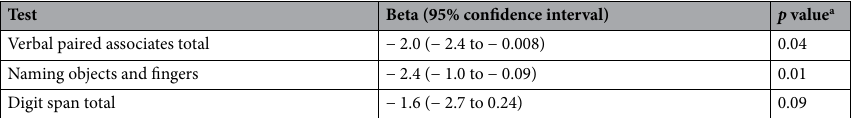
Table 3. Multivariate linear regression analysis testing the association between pregnancy and different cognitive tests. a Adjusted for age and numbers of years of